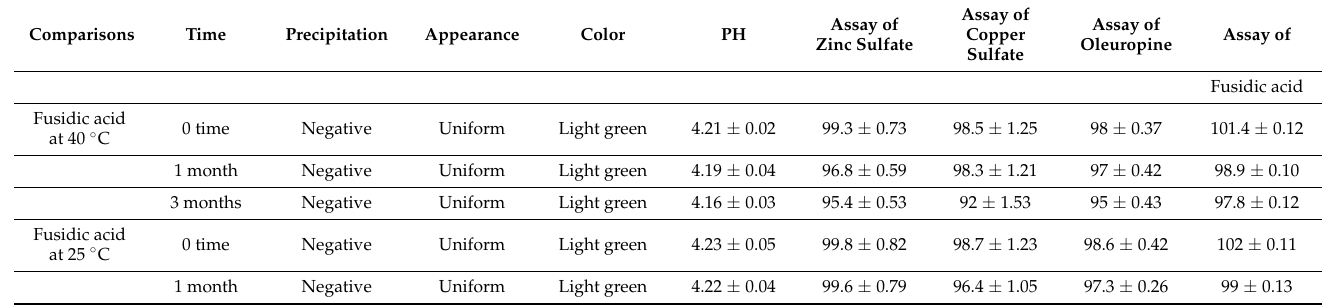
Table 7. Physical parameters and assay results (as percentage) of formula condition at zero time and